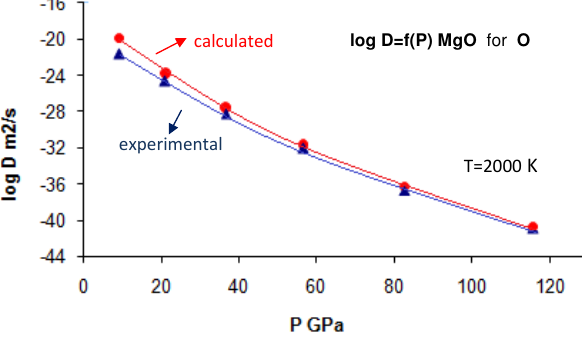
Figure captions Fig.1 color on line Pressure dependence of the self diffusion coefficient of O in MgO for T=2000K. Triangles denote the experimental data and solid circles the calculated ones.